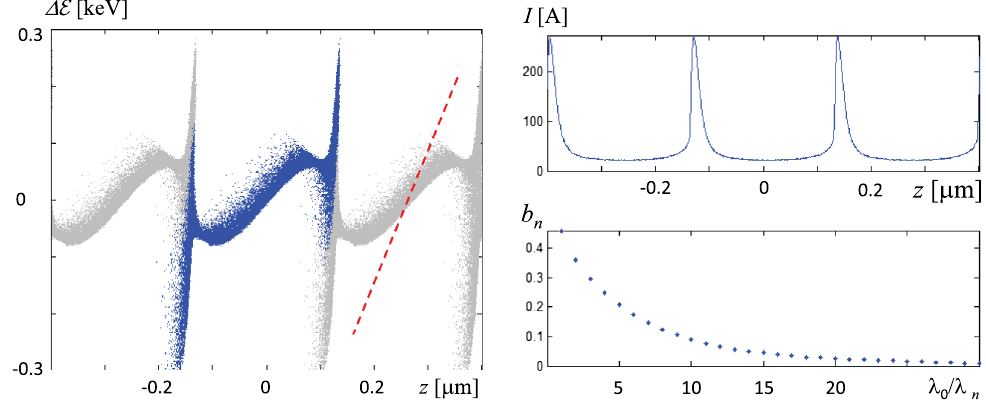
FIG. 14. Application B: longitudinal phase space, current and bunching after 3rd chicane, calculated with one dimensional impedance. Chicanes 2 and 3 are